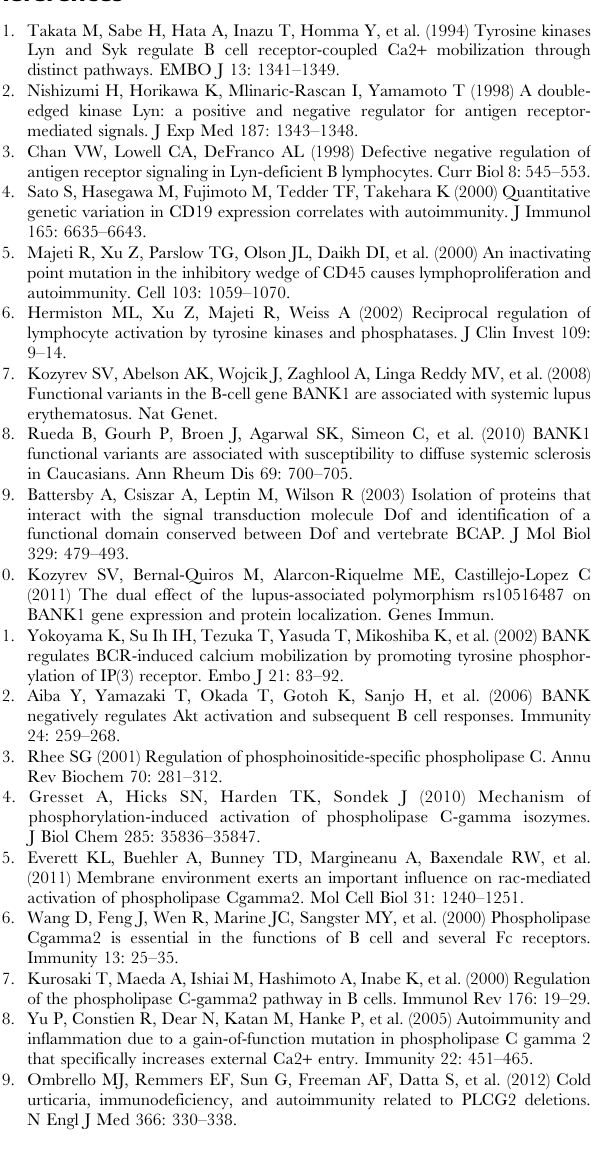
diamond = glycine, open square = threonine, dotted square = serine). Table S1 Complete set of prey proteins obtained in the Y2H screen using the truncated form of BANK1 (aa 331– 785). (XLSX) Method S1 ( A ). Primers used for cloning and fluorescence tagging of the expression constructsNote: Bases modified for cloning are indicated in uppercases and the start codons in italics.( B ) Primers used for directed mutagenesis.Mutated nucleo- tides are showed in lowercases. (DOC) Method S2 Confocal images were taken with a 40 6 objective and a pinhole of 3 in a LS 510 Zeiss microscope. Quantification of cells by DAPI